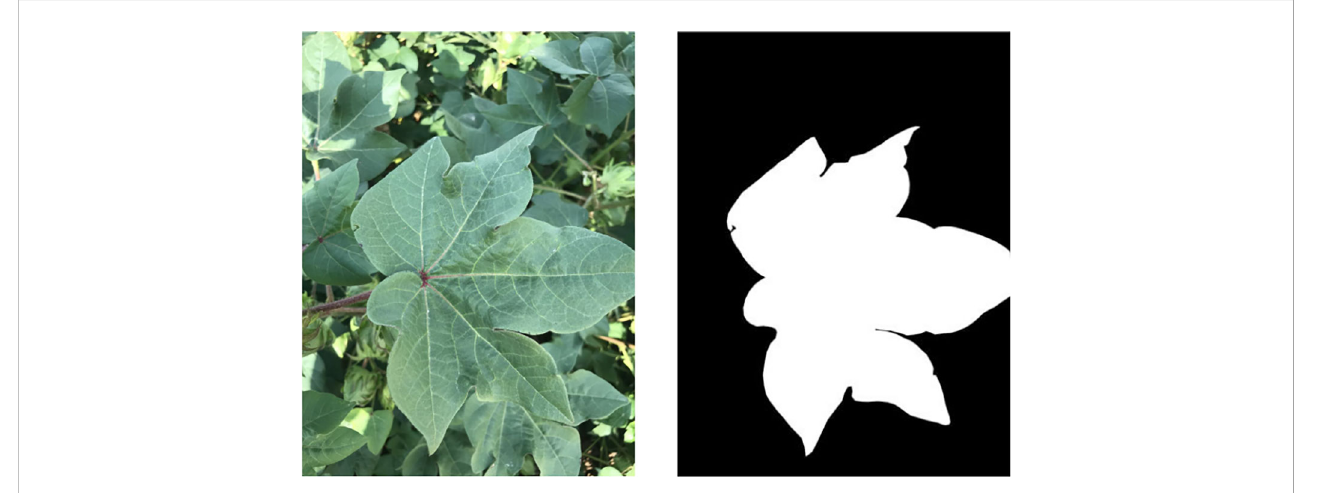
FIGURE 3 Image annotation process. The left is the input image, and the right is the labeled